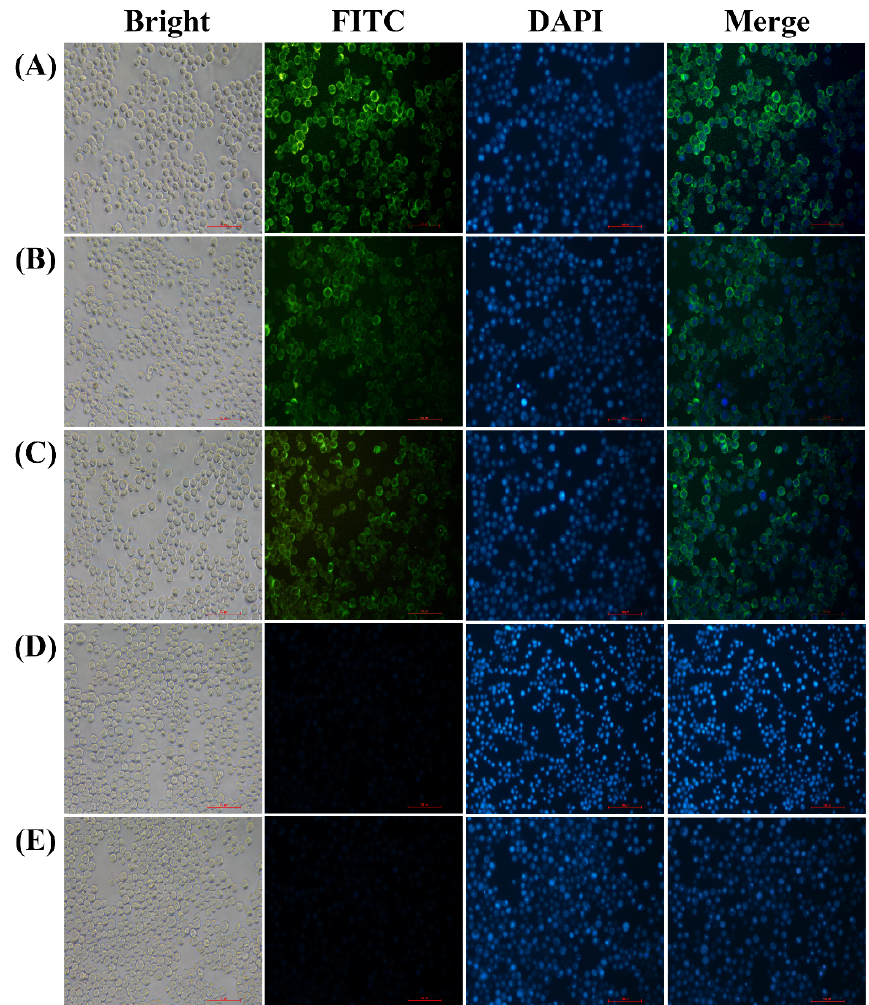
Figure 1. Immunofluorescent staining analysis of M, S and E protein expression in the recombinant baculovirus-infected Sf9 cells at 60 h post-infection (200×). ( A ) Sf9 cells infected with recombinant baculovirus rHBM-S. ( B ) Sf9 cells infected with recombinant baculovirus rHBM-M. ( C ) Sf9 cells infected with recombinant baculovirus rHBM-E. ( D ) Sf9 cells infected with wild-type baculovirus. ( E ) Sf9 cells. FITC was antibody conjugated (green); DAPI was used to stain cell nuclei (blue), and merging signified that FITC merged with